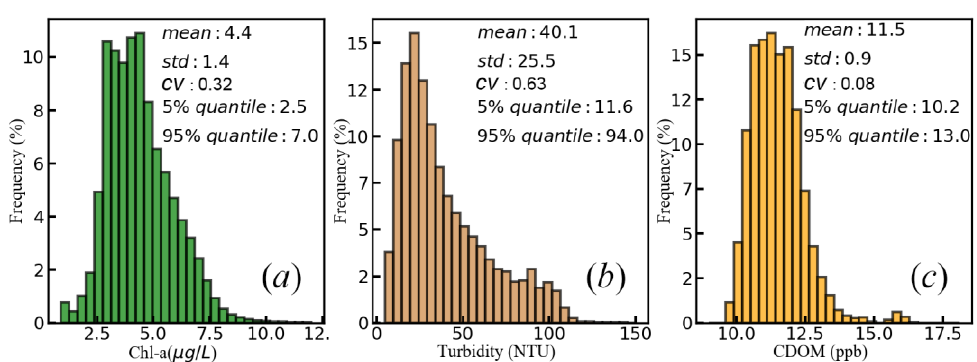
Figure 15. The histograms and several statistic indexes of retrieval results.